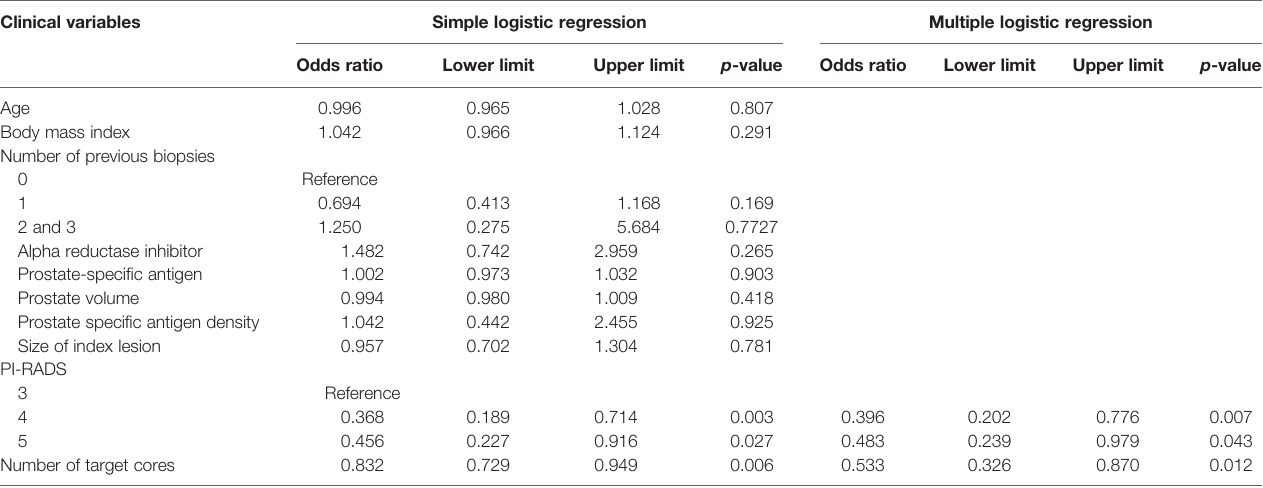
TABLE 1 | Clinical variables in fl uencing GS upgrade with univariate and multivariate analyses. Clinical variables